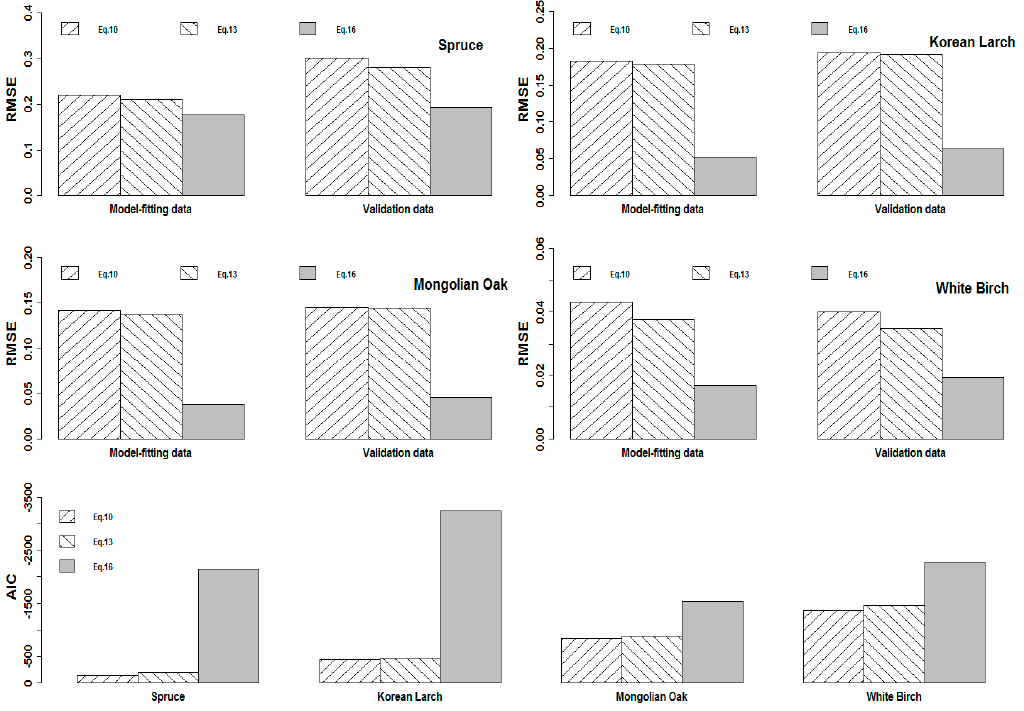
Figure 2. Comparisons of performance among Equations (10), (13), and (16) for Spruce, Korean Larch, Mongolian Oak, and White Birch based on root mean square error ( RMSE ) and Akaike’s information criterion ( AIC ) using both model-fitting and validation data sets.